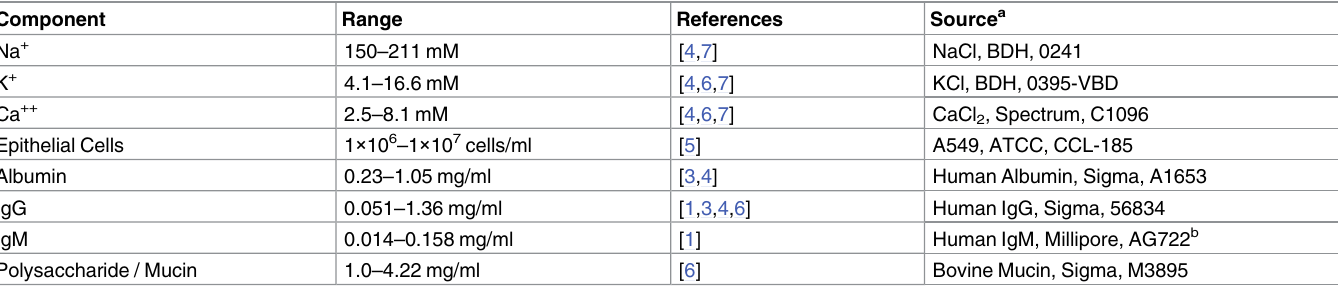
Table 1. Simulated respiratorysecretion components and